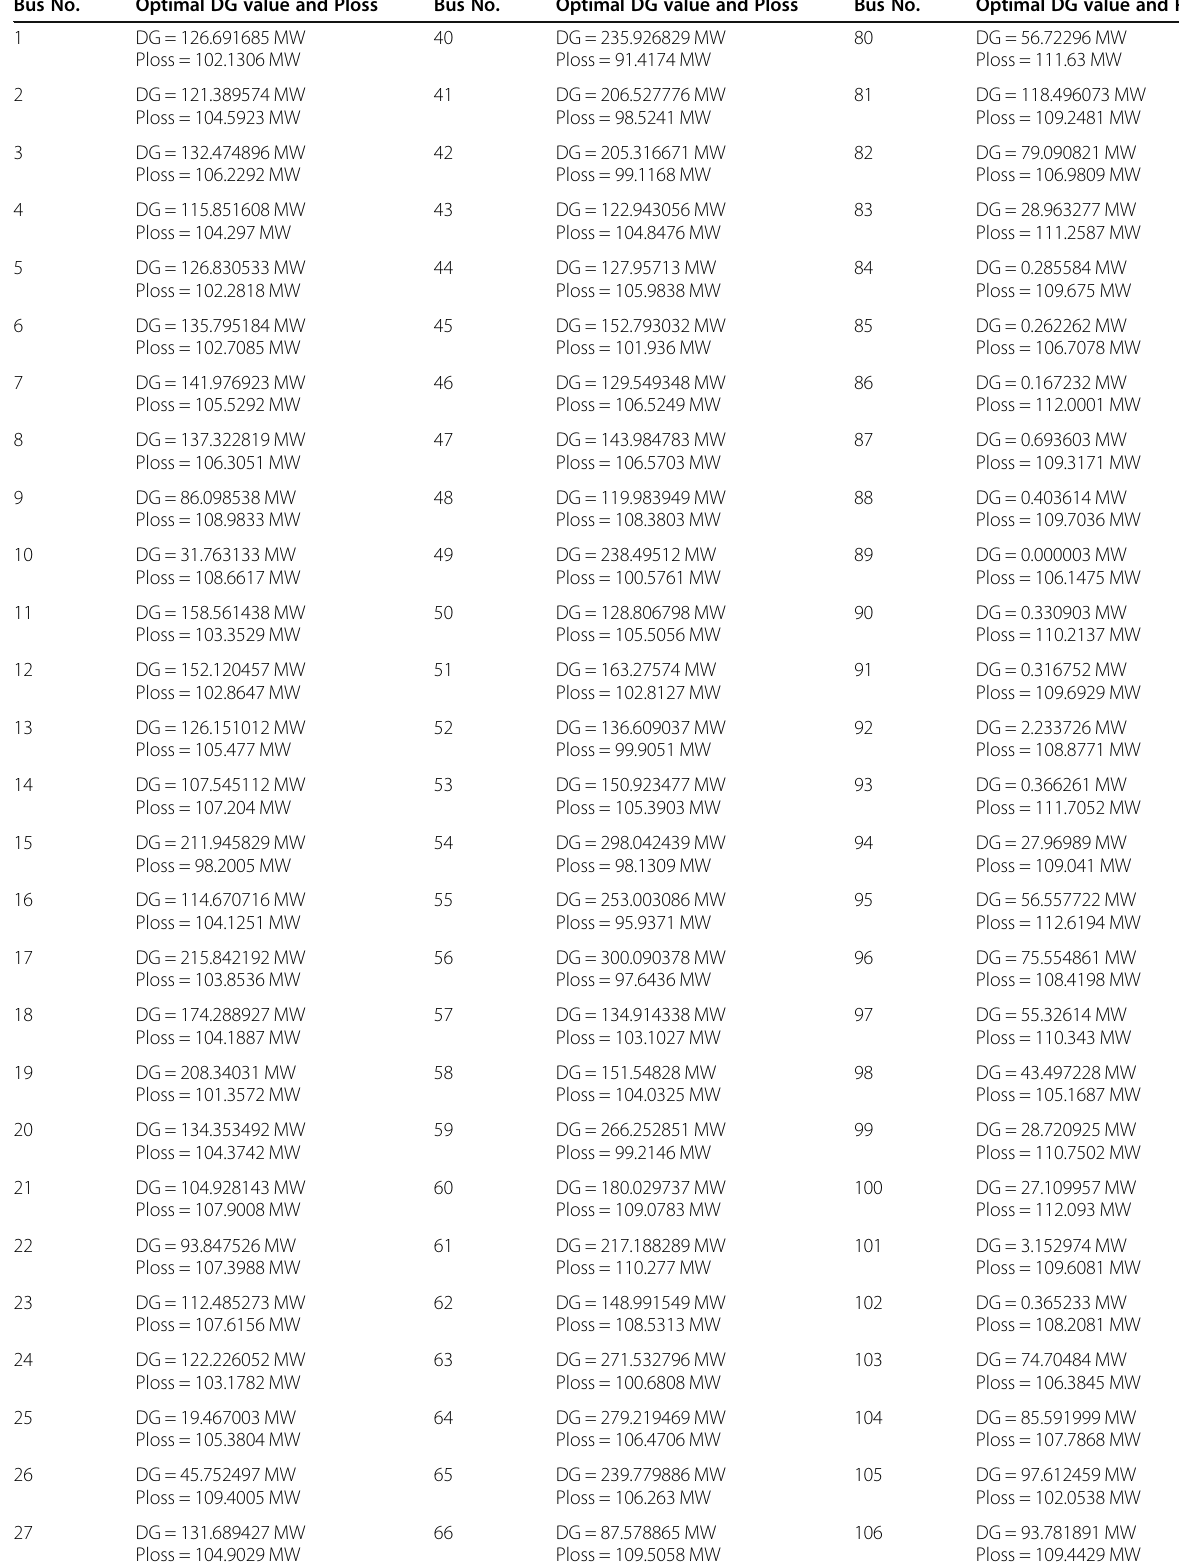
Table 22 Optimum solution for the IEEE 118 bus system with DG individually injected at each bus using JAYA algorithm Bus